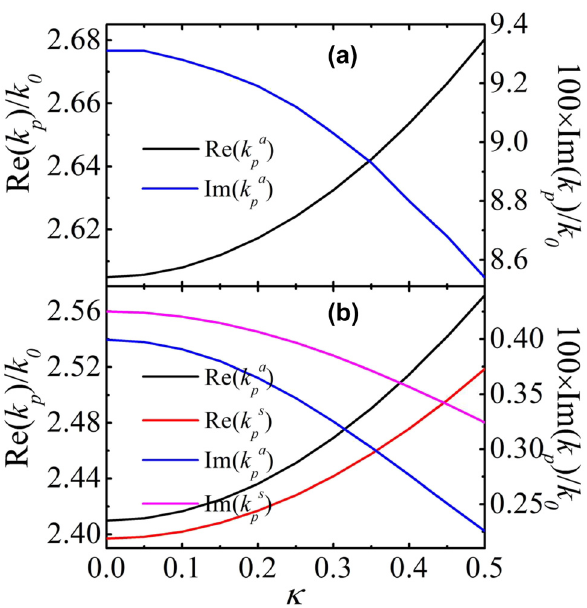
Figure 3: The electric field distribution of the symmetric mode for all three directions. The field amplitudes are normalized by the maximum value of z direction component. Here, d 𝜅 =